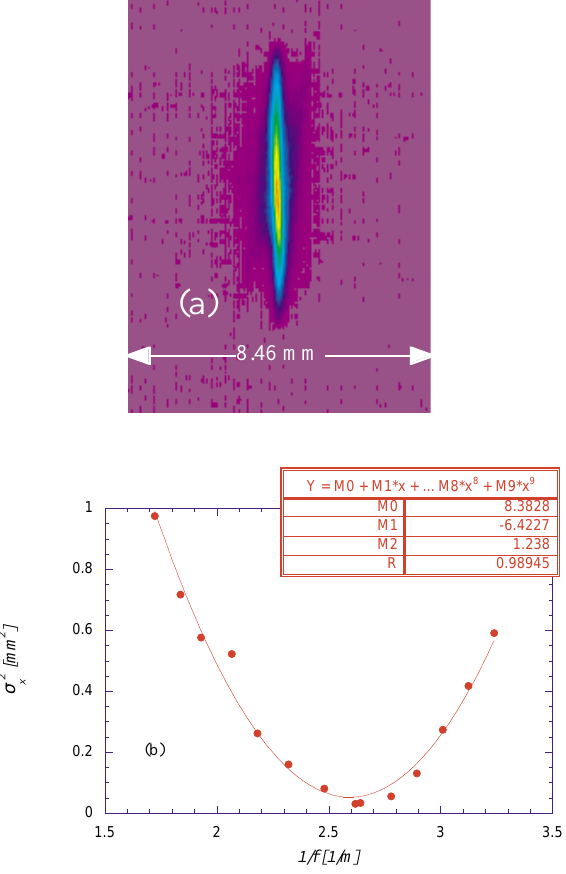
FIG. 4. (Color) (a) False color image of a beam image used in a quadrupole scan. (b) Result of one quad scan. The normalized horizontal emittance found from the curve fit is 9.6 6 1.1 mm